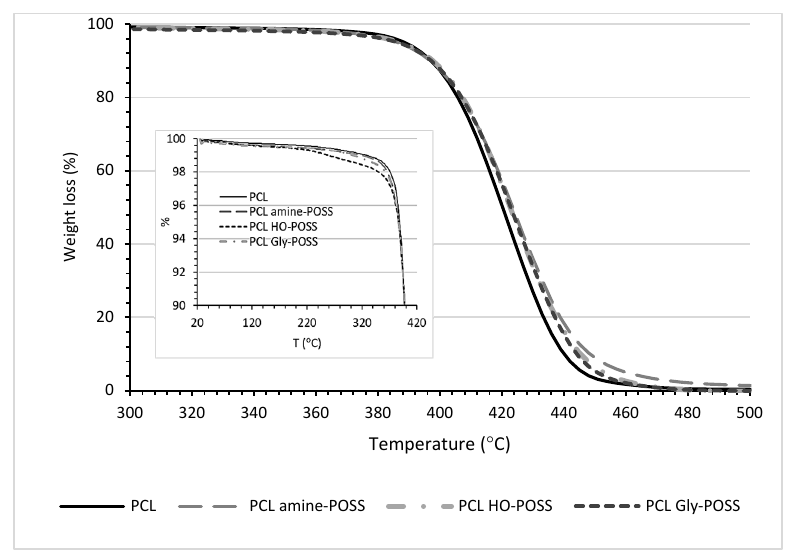
Figure 4. TGA plots for PCL POSS samples.